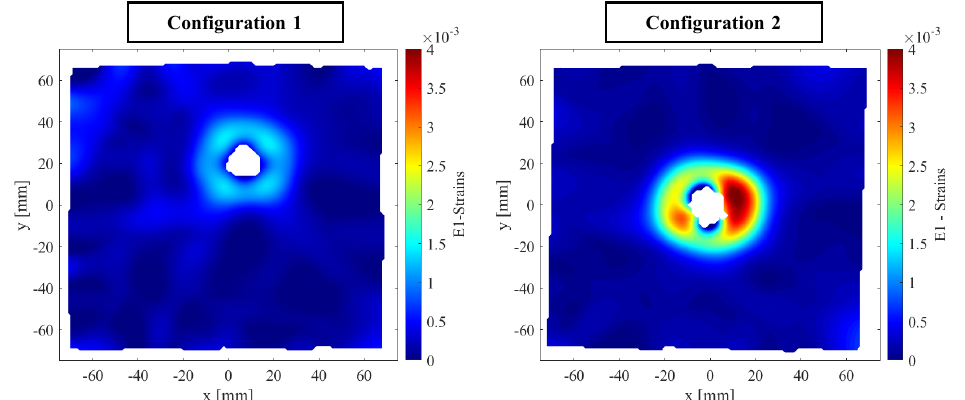
Figure 9. Comparison between the major principal strain fields of 7.62 mm ( left ) and 12.7 mm ( right ) FSP perforation.